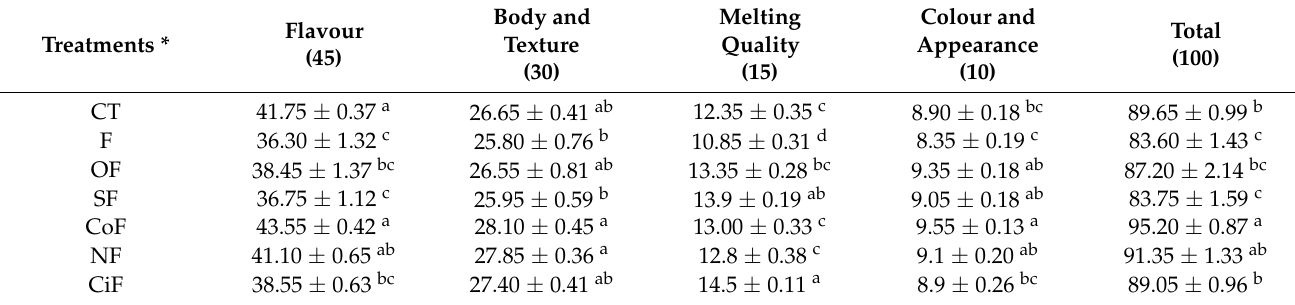
* Refer to Materials and Methods for details. Data are expressed as Mean ± SE for 3 replicates. Different superscripts letters (a, b, c and d) indicate statistical significance between different treatments using chufa milk and other flavoring materials. Means within the same column with different superscripts differ at p ≤